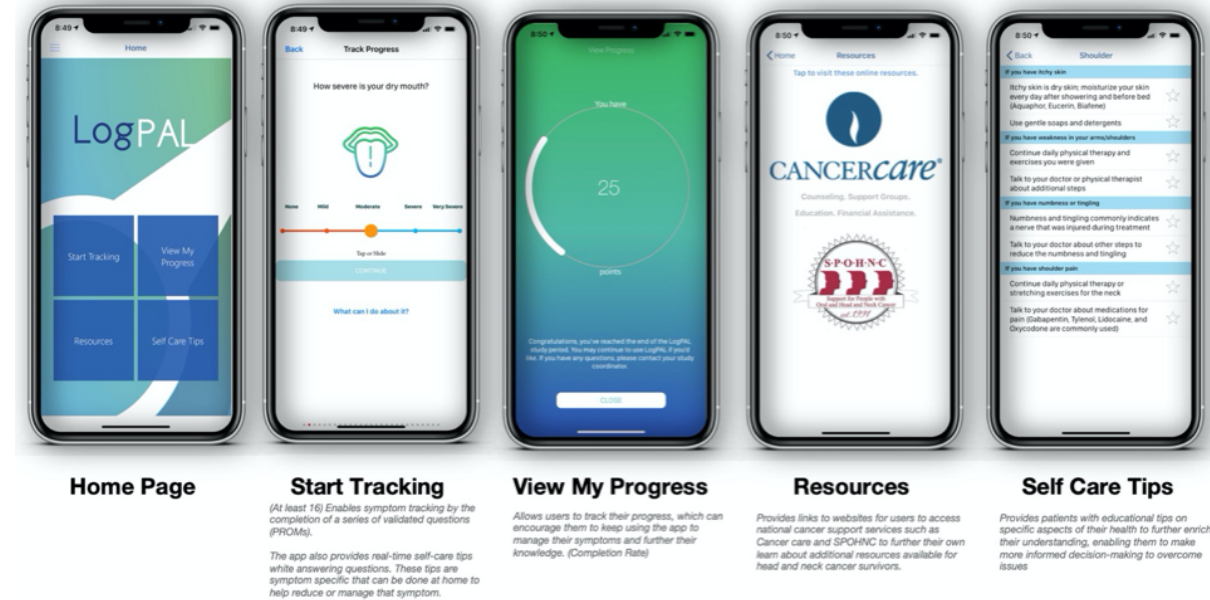
Figure 1. Snapshots and overview of the LogPAL app features.